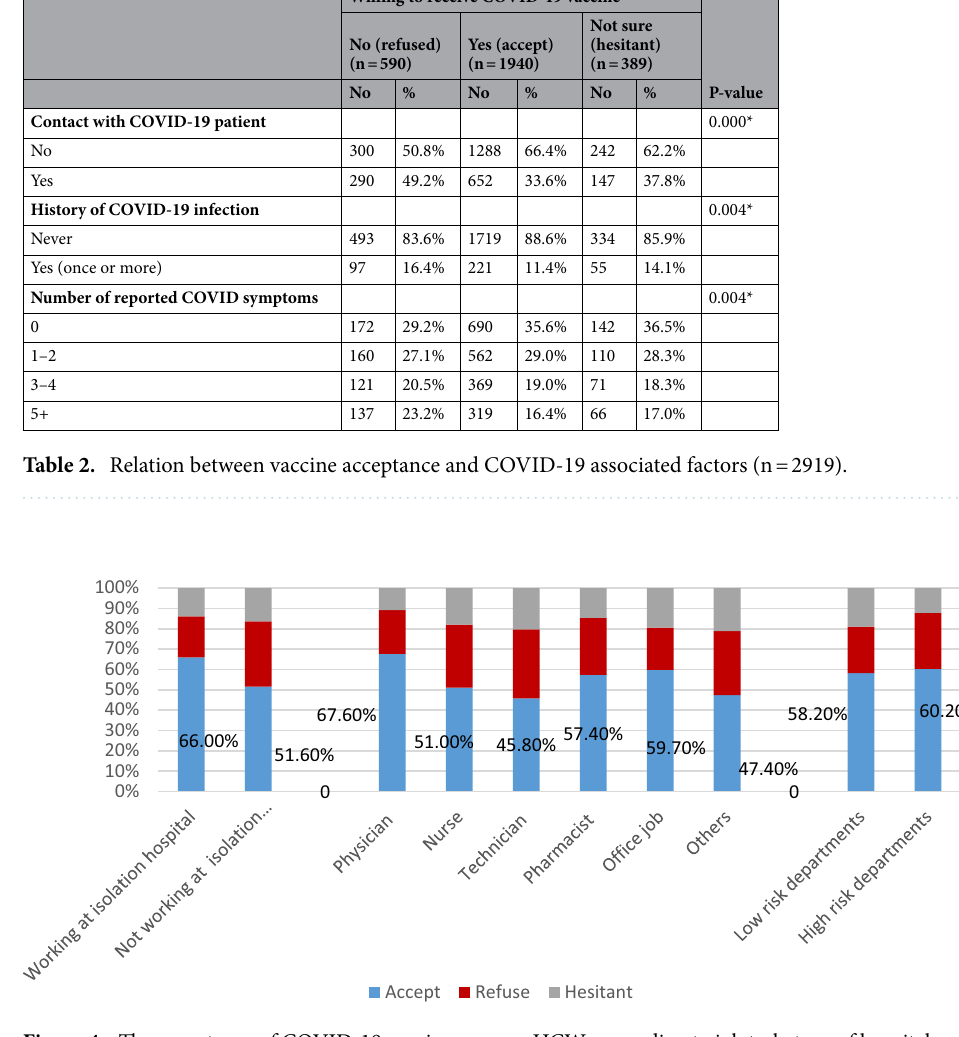
Figure 4. The acceptance of COVID-19 vaccines among HCWs according to job task, type of hospital and